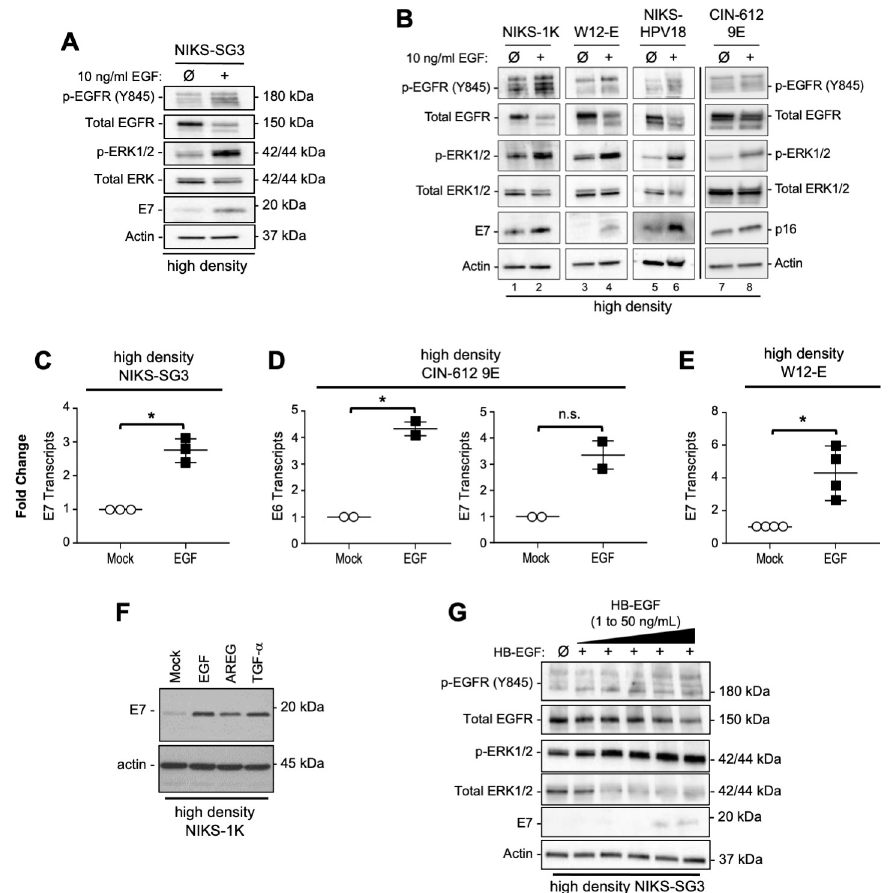
Fig 4. EGFR ligands rescue cell density-dependent suppression of EGFR/MEK/ERK signaling and HPV oncogene expression in HPV16(+) and HPV31(+) cells. (A-E) Cells were seeded at high cell density (1.3 x 10 5 cells/cm) and allowed to attach overnight; cells were then treated with or without 10 ng/ml EGF for 24h before harvest. (A,B) Proteins (25 μ g) subject to SDS-PAGE and IB. (B) In lanes 1–6, E7 proteins were detected; lacking antibodies to HPV31 E7 protein, p16 was detected as an E7 surrogate (lanes 7–8). (C-E) Total mRNAs extracted from replicate cultures were subjected to RT-qPCR targeting HPV oncogene mRNA; cDNA levels were normalized to ribosomal protein 18s mRNA levels and unstimulated sample. Scatterplots represent the mean and range of the data as analyzed by Welch’s t-test ( � p < 0.05). (F) High density cells were treated with 10 ng/ml each of EGF, AREG or TGF- α for 48h; proteins were subject to SDS-PAGE and IB. (G) Cells seeded at a high cell density were treated 24h with increasing concentrations of HB-EGF; proteins were subject to SDS-PAGE and IB.